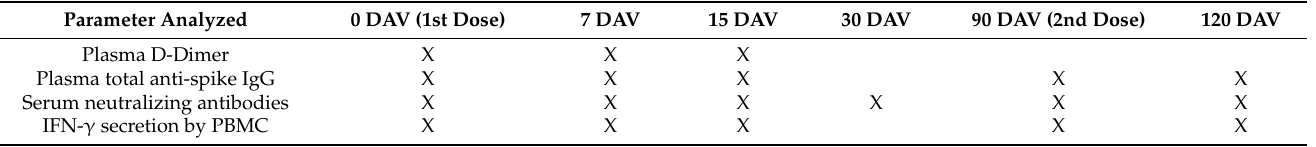
Table 2. Techniques applied according to days after